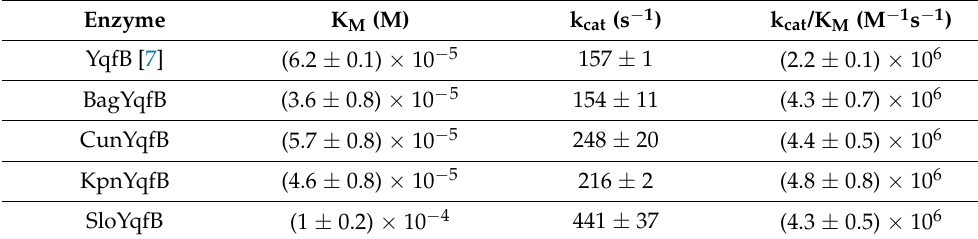
Table 2. Kinetic parameters of YqfB and ASCH domain-containing YqfB-like proteins. The activity was measured in 20 mM Tris-HCl, pH 7.5, at 22 °C, using ac4C as a substrate.